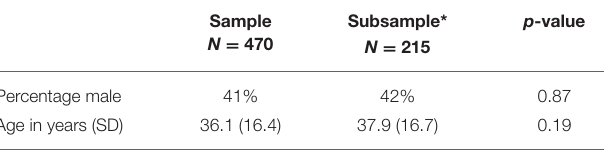
TABLE 1 | Demographics of the population-based sample (BIG study).